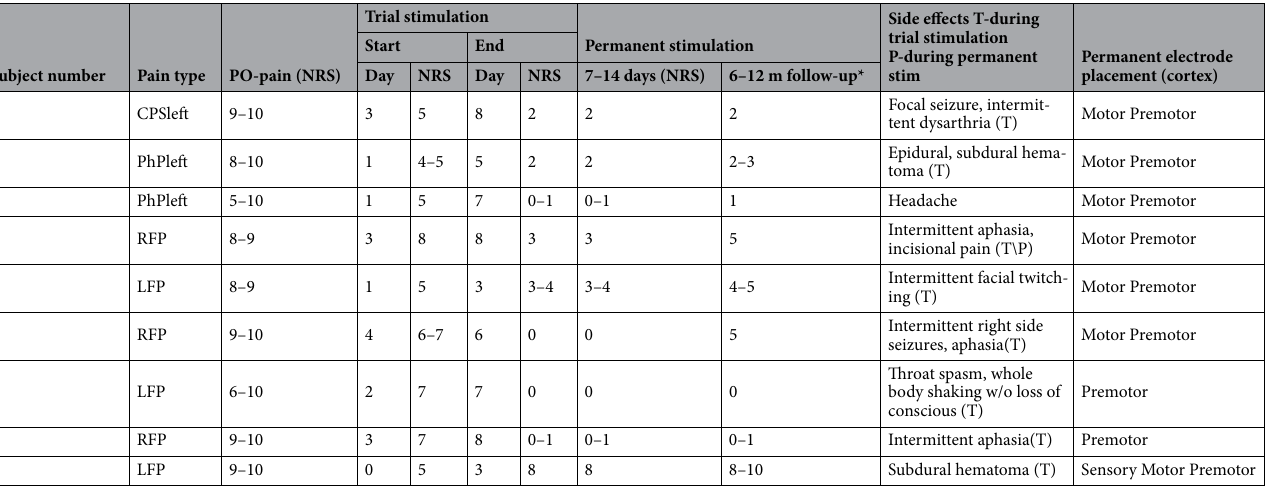
Table 2. Results of trial stimulation with temporary and permanent grid. PO pain-preoperative pain level; Trial stimulation—mapping with temporary grid stimulation: start day—days after temporary grid implantation; start NRS—pain by the trial stimulation beginning; end day—trial stimulation end after temporary grid implantation; end NRS—pain by the end of trial stimulation; Chronic stimulation— stimulation with permanent grid: *NRS score within 6–12 months of observation is considered as an average pain level during this period that achieved after stimulation parameters adjustment and adequate battery charge. CPS left—central poststroke pain syndrome with left-side clinical presentation; PhP left–left side phantom pain, RFP–right fascial pain; LFP–left fascial